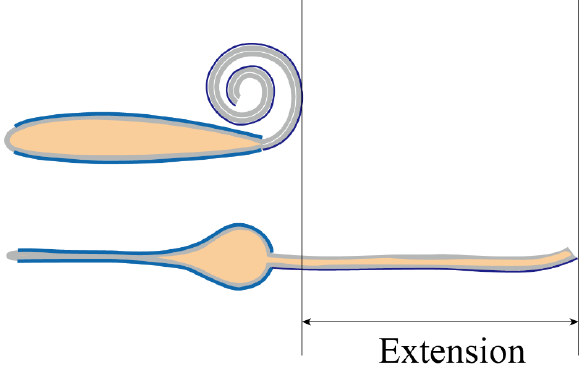
Figure 10. Illustration of the extension of the BSPA.